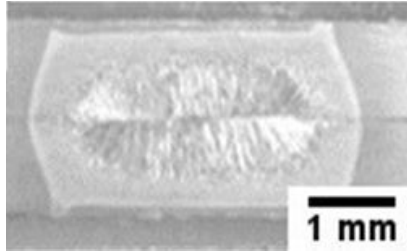
Figure 9: Macrostructure of AHSS-DP800 RSW joints